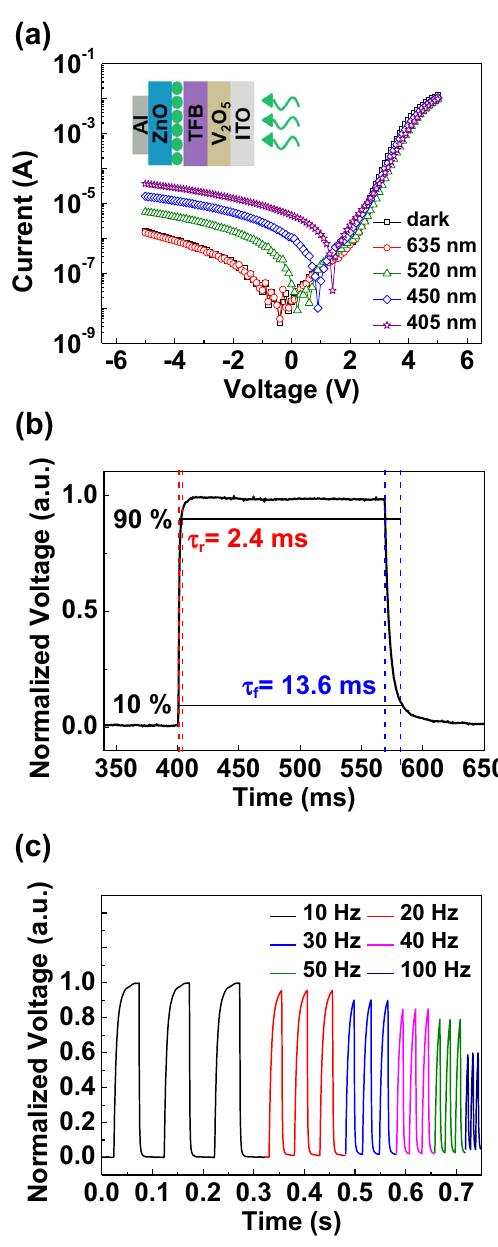
Figure 4. ( a ) Transfer curves of the device in a dark state and with the illumination of various wavelengths light. Inset shows a schematic illustration of the QLEDs with 5 wt% V 2 O 5 for the light detecting process. ( b ) Photo response characteristics of the device. Rising and falling time was defined as the interval between 10 and 90% of the signal. ( c ) Normalized photo responses according to the different speed of turn on and off the 520 nm wavelength light